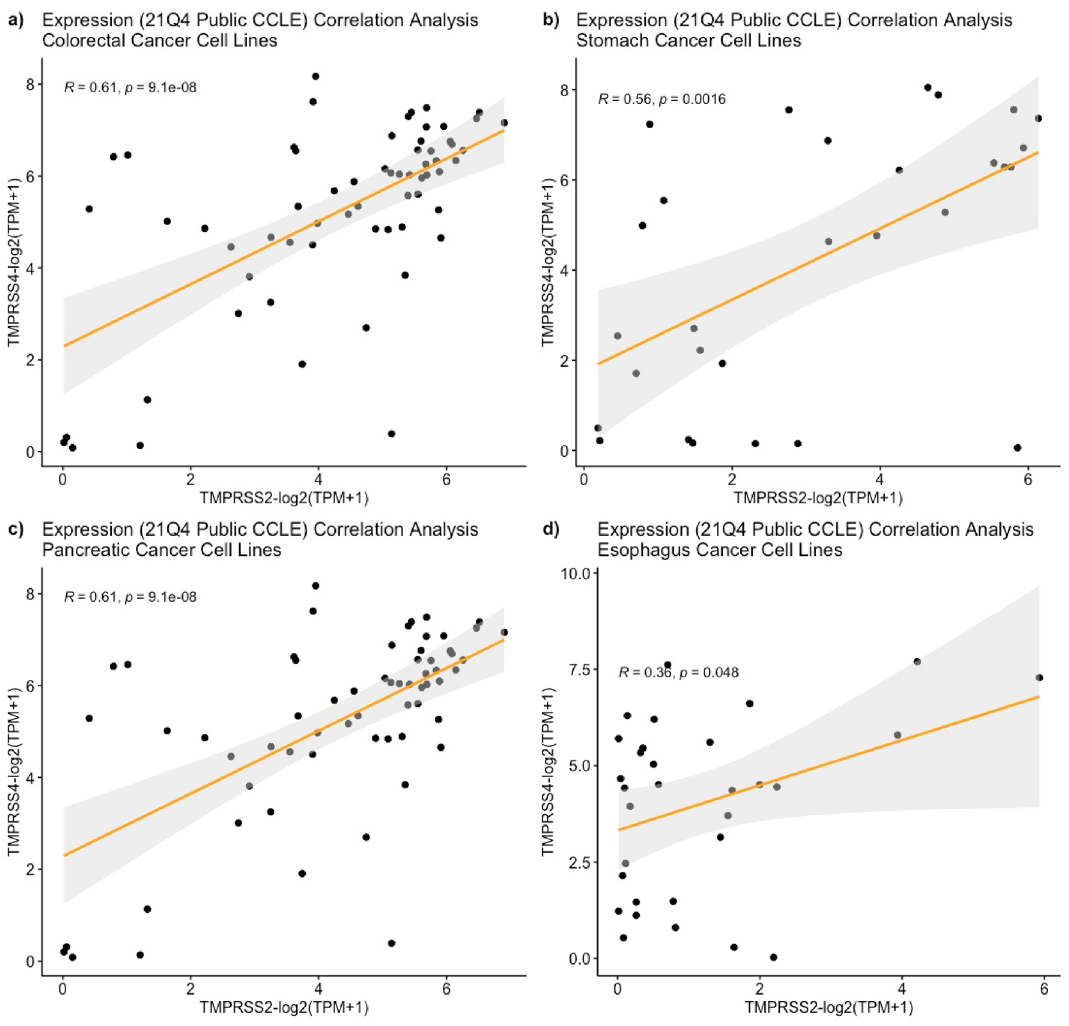
Figure 3. Positive correlation between TMPRSS2 and TMPRSS4 in gastrointestinal cancer cell lines from CCLE database. For colorectal ( a ), stomach ( b ) and pancreatic ( c ) cancer cell lines, R-value > 0.5 and for esophagus cancer cell lines ( d ) R-value > 0.3 while p-values for all of them <